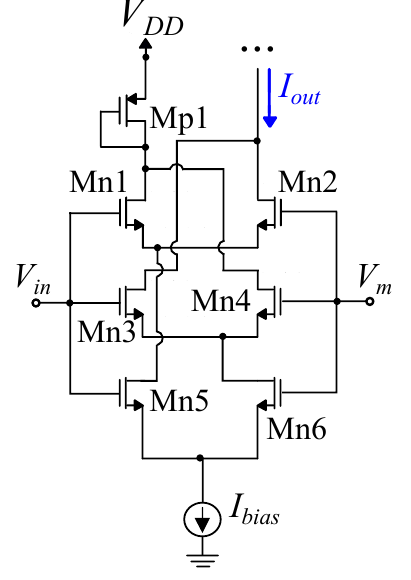
Figure 25. Gilbert’s Gaussian